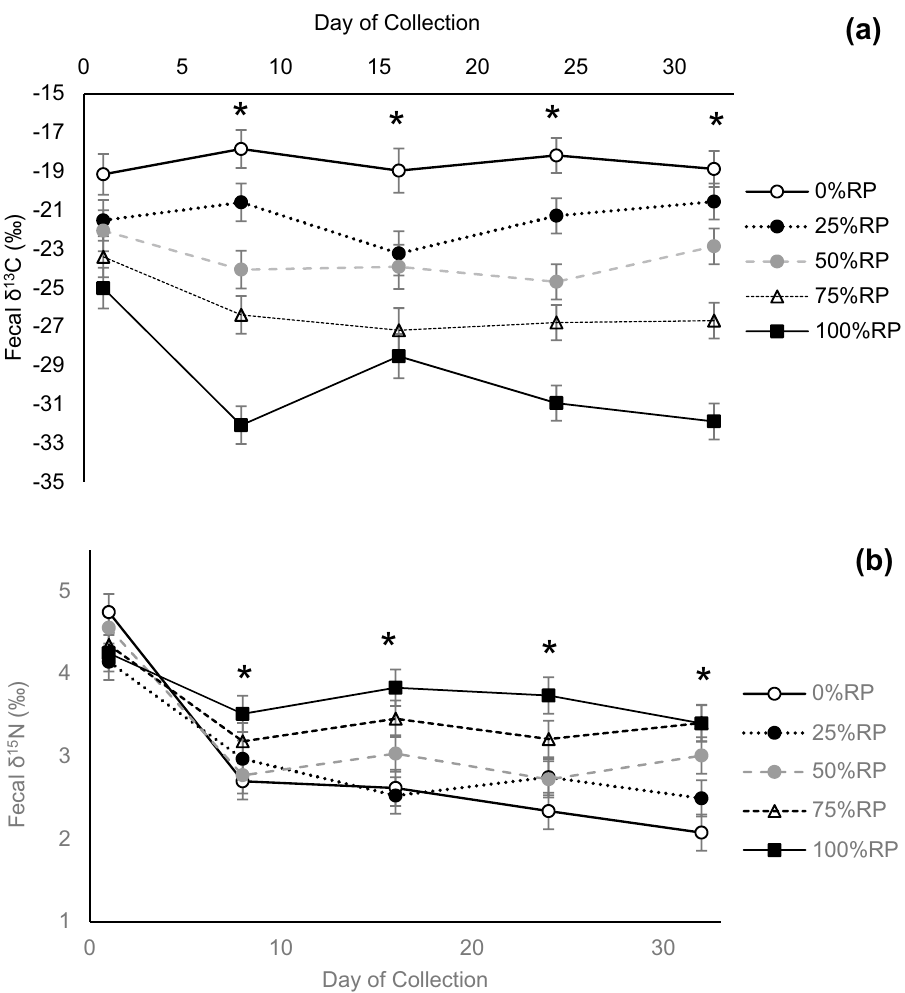
Figure 1. δ 13 C ( a ) and δ 15 N ( b ) feces of beef cattle consuming increasing proportions of rhizoma peanut (RP) in bahiagrass hay. Day of collection represents the number of days after dietary change. Asterisk indicates treatment differences ( P ≤ 0.05) exist within the day of